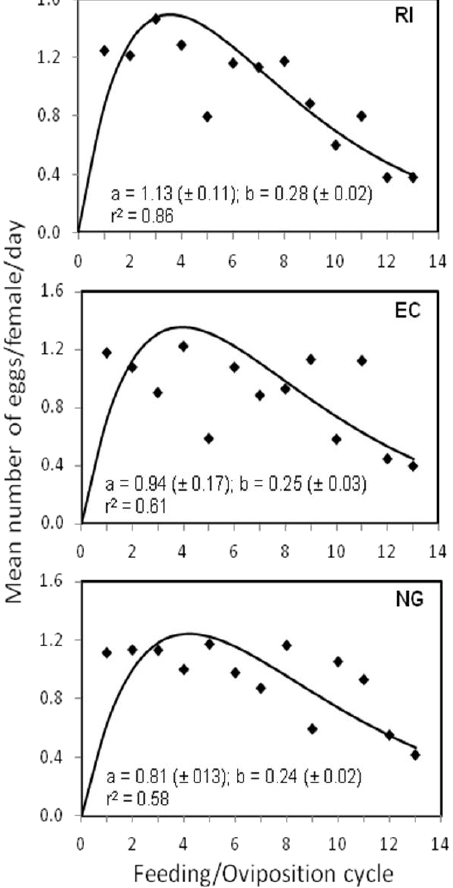
Figure 1. Mean number of eggs/female/day (filled diamonds) and fit of the model [ Y = aX exp(− bX ), solid line] to these data for three strains of the common bed bug (Richmond-RI, Epic Center-EC, and Nottingham Green-NG) over the course of 13 feeding/oviposition cycles. Shown are estimates of the model parameters (±SE).